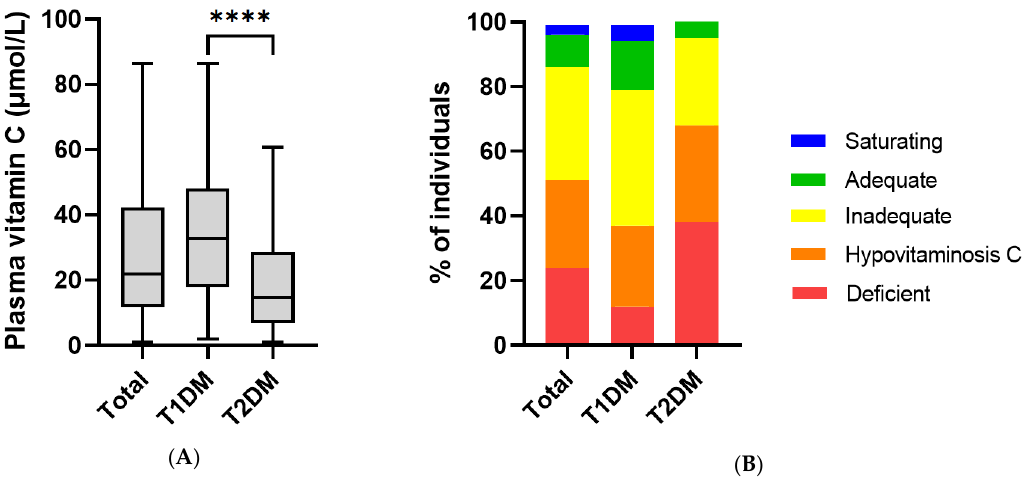
Figure 2. Vitamin C status in patients with T1DM and T2DM: ( A ) box plots show median, borders the 25th and 75th percentiles and whiskers the range; **** p < 0.0001 (Mann–Whitney U test). ( B ) Vitamin C categories: deficient ≤ 11 µmol/L; hypovitaminosis C ≤ 23 µmol/L; inadequate <50 µmol/L; adequate ≥ 50 µmol/L; saturating ≥ 70 µmol/L.